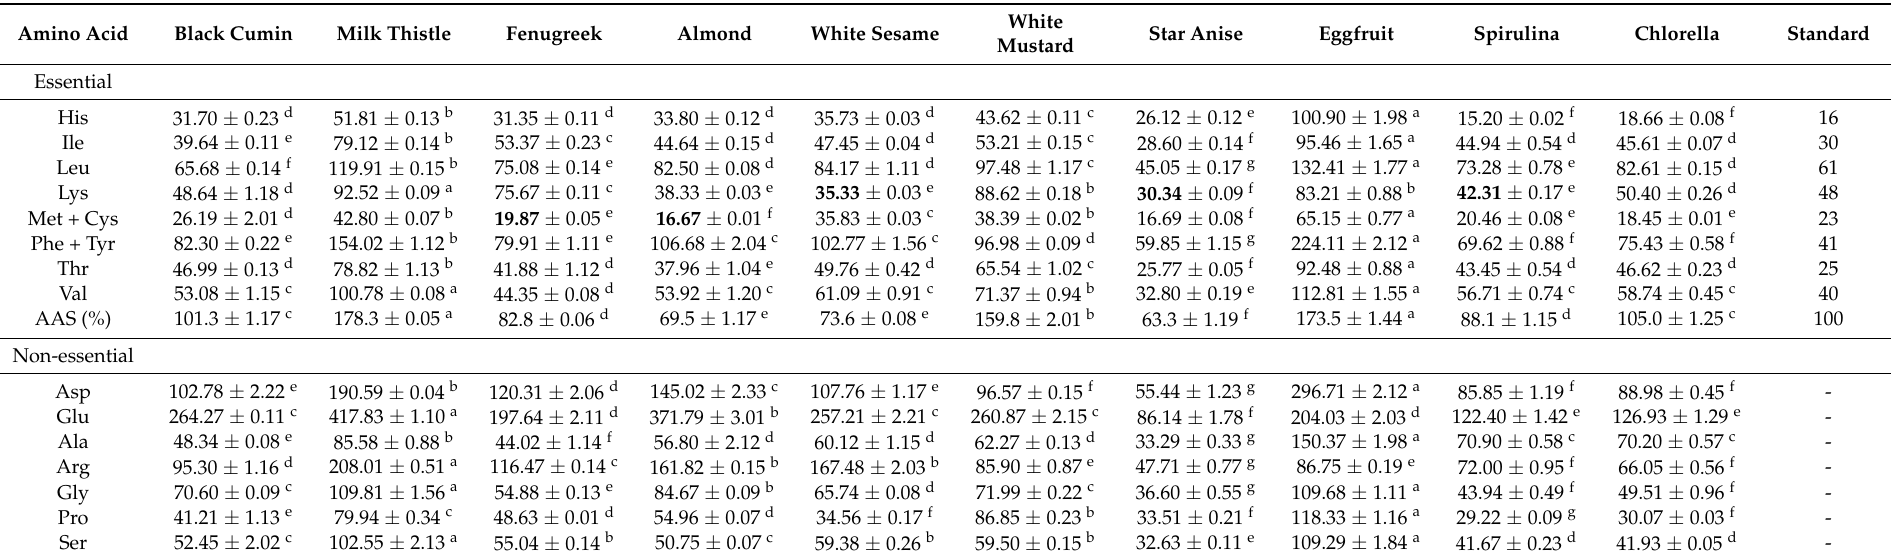
Data are means of two replicates. a–g, the same letters in columns mean homogenous groups; bold values indicate first limiting amino